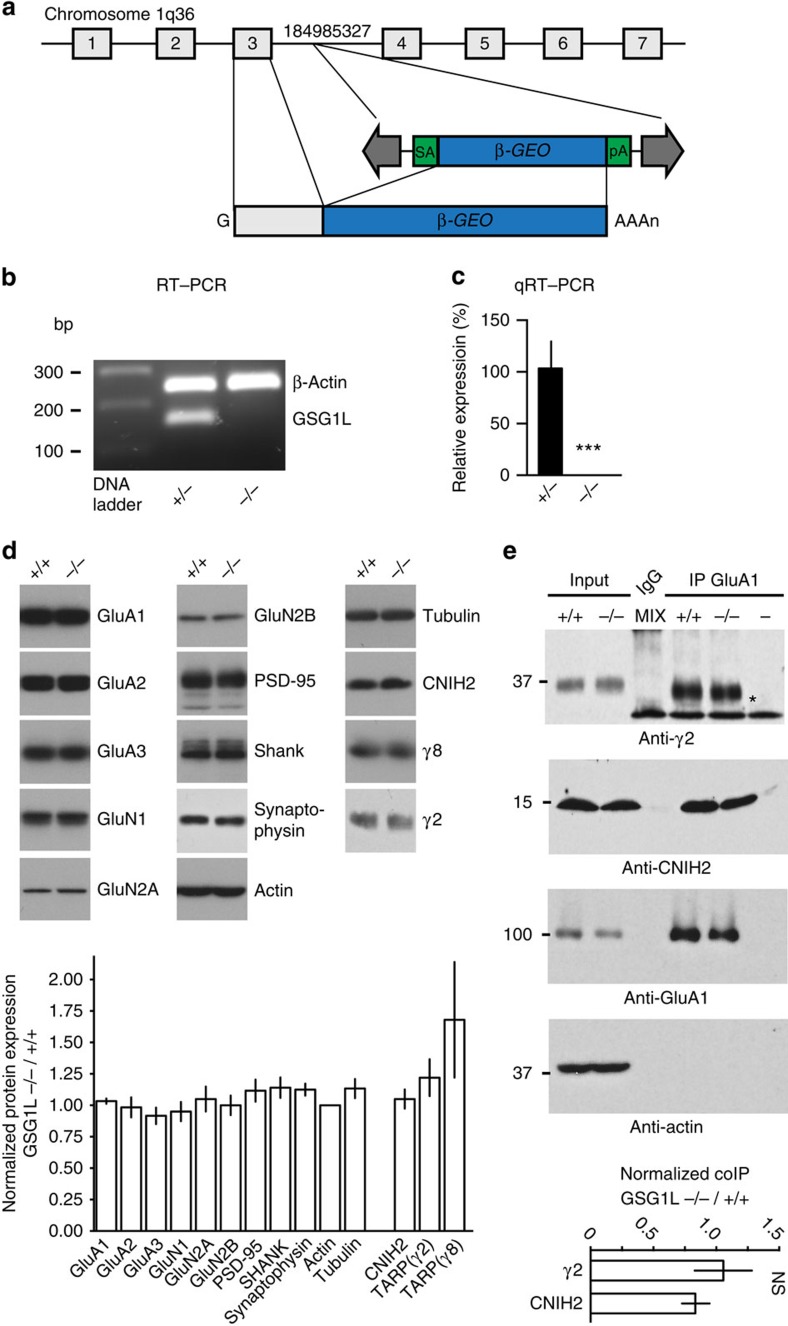
Characterization of Gsg1l knockout (KO) rats.(a) Schematic outline of a Sleeping Beauty gene trap in intron
3 of rat Gsg1l. SA, splice acceptor; pA, poly A. (b) Reverse
transcription–PCR (RT–PCR) showed no detectable GSG1L mRNA in
the hippocampal tissues of KO (−/−) rats. (c)
Quantitative real-time RT–PCR (qRT–PCR) showed that homozygous
GSG1L KO (−/−) rats lacked GSG1L mRNA in the hippocampal tissue
as compared with the heterozygous rats (P<0.001, t-test).
(d) Bar graph shows normalized expression of various synaptic
proteins (GSG1L KO/WT). Six sets of hippocampi were dissected from
P14–17 WT (+/+) and GSG1L KO (−/−) rats.
Proteins prepared from crude synaptosomal membranes were immunoblotted,
quantitated and normalized (n=6, P>0.05, One-way
ANOVA test). Sample blots for each protein are shown above the bar graph.
(e) Immunoprecipitation experiments in +/+ and
−/− hippocampal lysates. Bar graph in the bottom shows that TARP
γ2 and CNIH2 associated with GluA1 at comparable levels in
+/+ and −/− hippocampal lysates (mix: mix of proteins
from +/+ and −/− (50%/50%);
‘−', only lysate buffer without protein lysates;
‘*', TARP γ2-specific signal; n=3,
P>0.05, t-test). Statistical significance is presented
as ***P<0.001. NS, not significant.